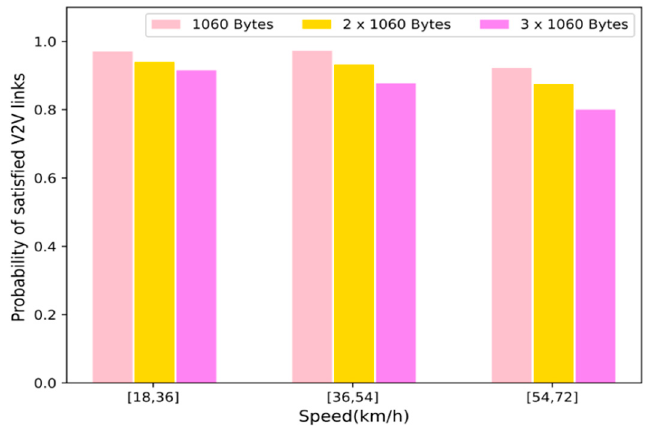
Figure 4. V2V payload transmission success probability with varying vehicle speeds.